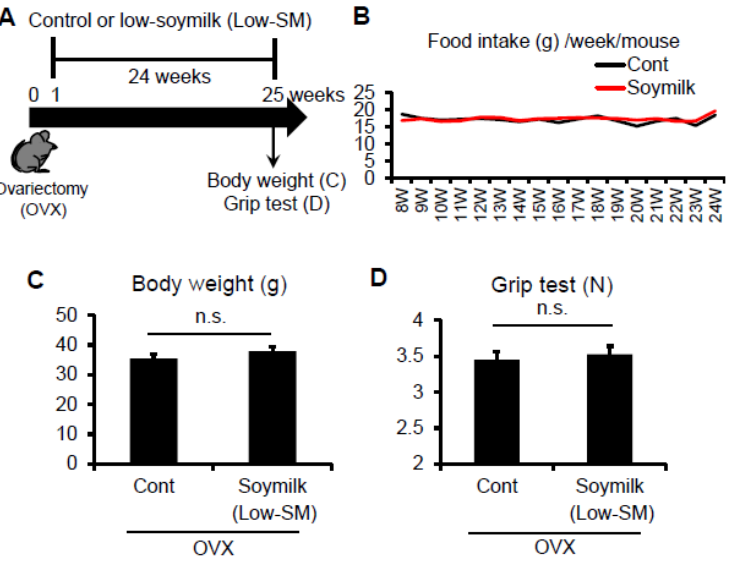
Figure 1. Effect of Low-SM intake on grip strength in OVX mice. ( A ) Six-week-old female C57BL/6 mice were ovariectomized (OVX) and fed with low-soymilk (Low-SM) for 24 weeks, started from 1 week after ovariectomy. Muscle strength was measured by a grip strength meter. Food intake ( B ), body weight ( C ), muscle strength ( D ) were shown (control, n = 9; soymilk, n = 10 mice). Data represent the mean ± SEM. n.s., not significant.